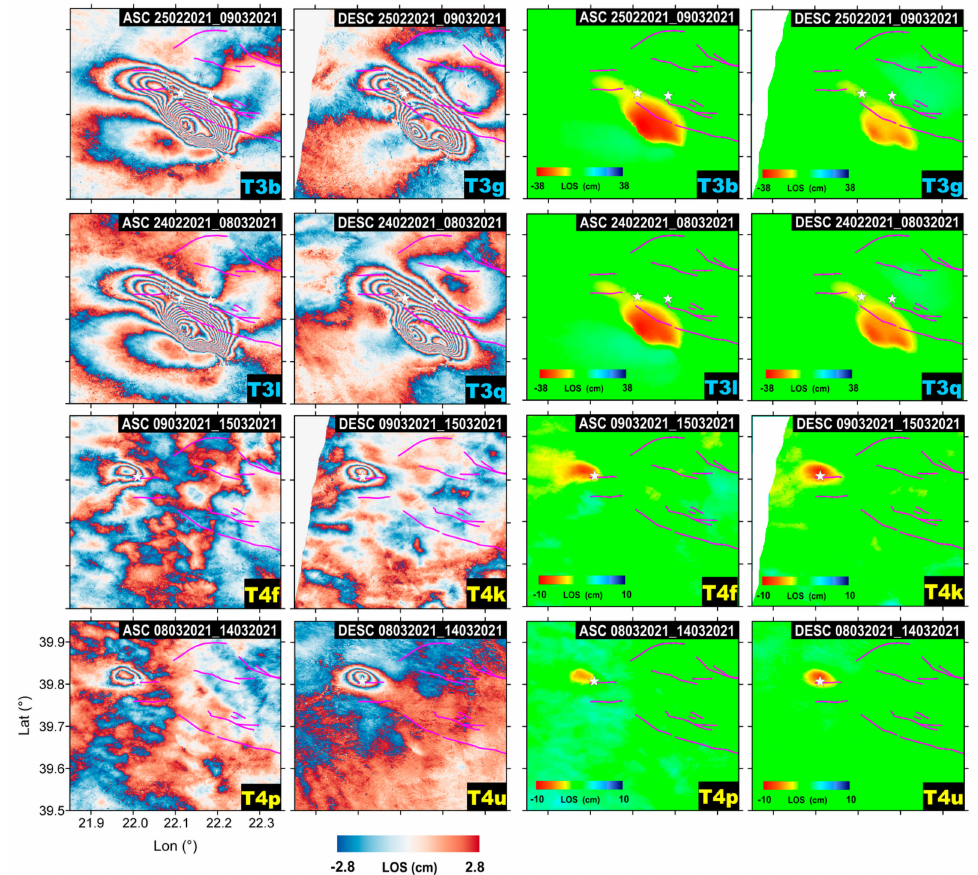
Figure 3. InSAR interferograms. A selection of Sentinel-1 InSAR interferograms used in this study ( first two columns ) and corresponding unwrapped data ( last two columns ). Fault lineaments and epicenters of the three largest events are indicated with magenta lines and white stars, respectively. Displacements are in satellite line-of-sight